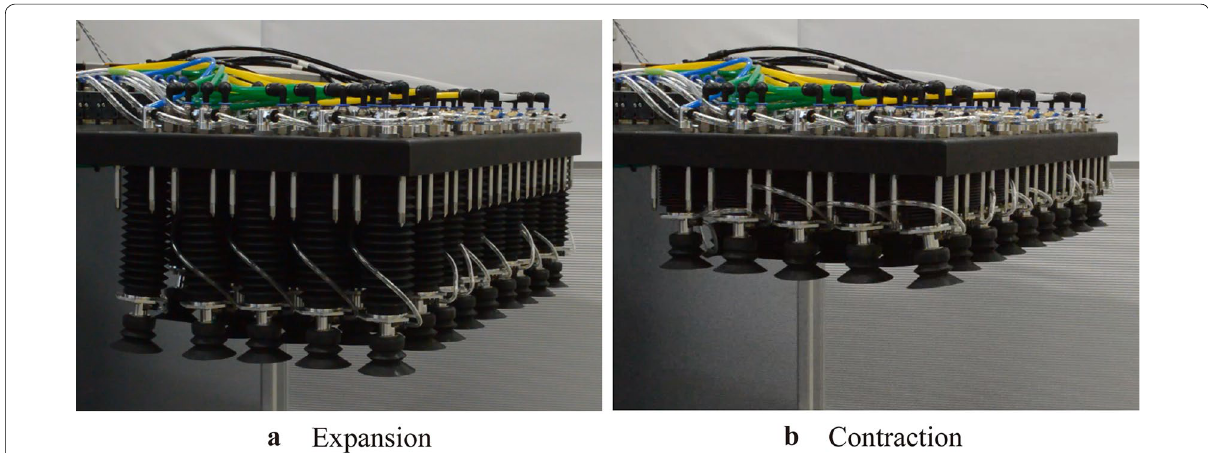
Fig. 24 Basic expansion and contraction motions of each suction pad unit of the end effector. a Expansion, b contraction